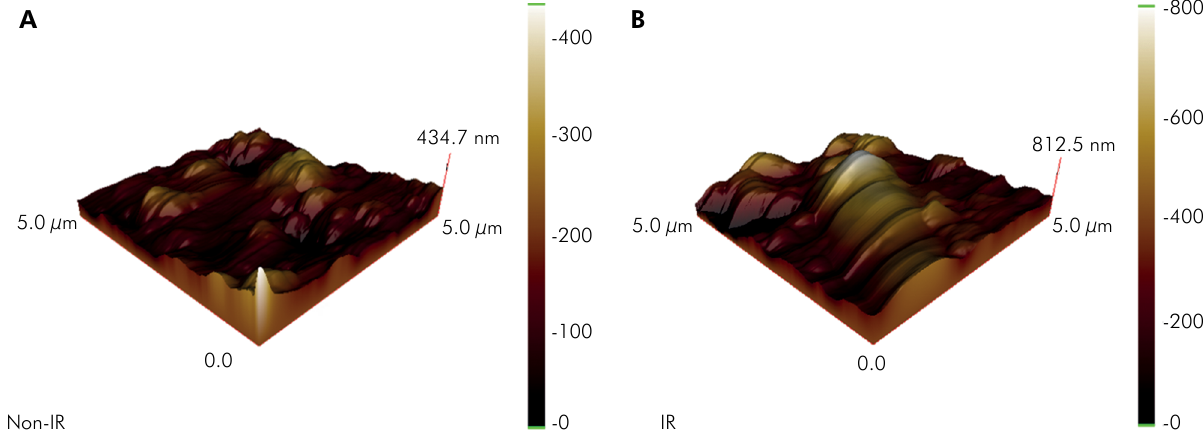
Figure 2. A: AFM image of Zirconomer in the Non-IR (non-irradiated) subgroup. The topographical AFM 3D-images were acquired in the contact mode from 5 × 5 μ m area; B: AFM image of Zirconomer in the IR (irradiated) subgroup. The topographical AFM 3D-images were acquired in the contact mode from 5 × 5 μ m